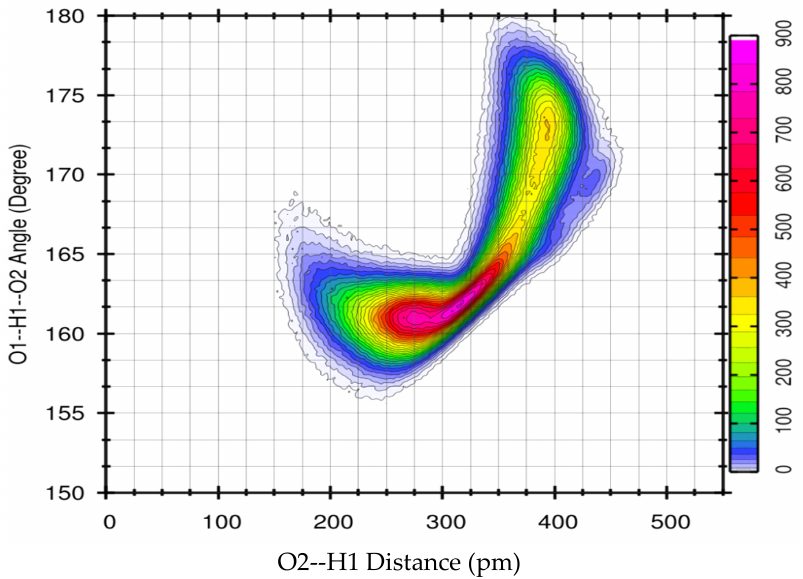
Figure 6. EG: Combined radial and angular distribution function for intramolecular H-bond.